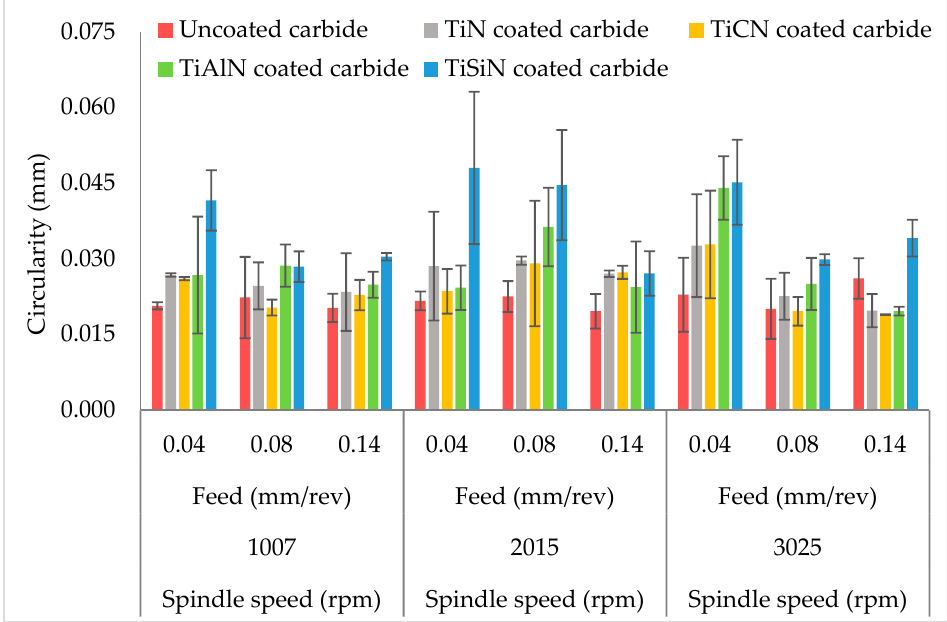
Figure 3. Average circularity error .